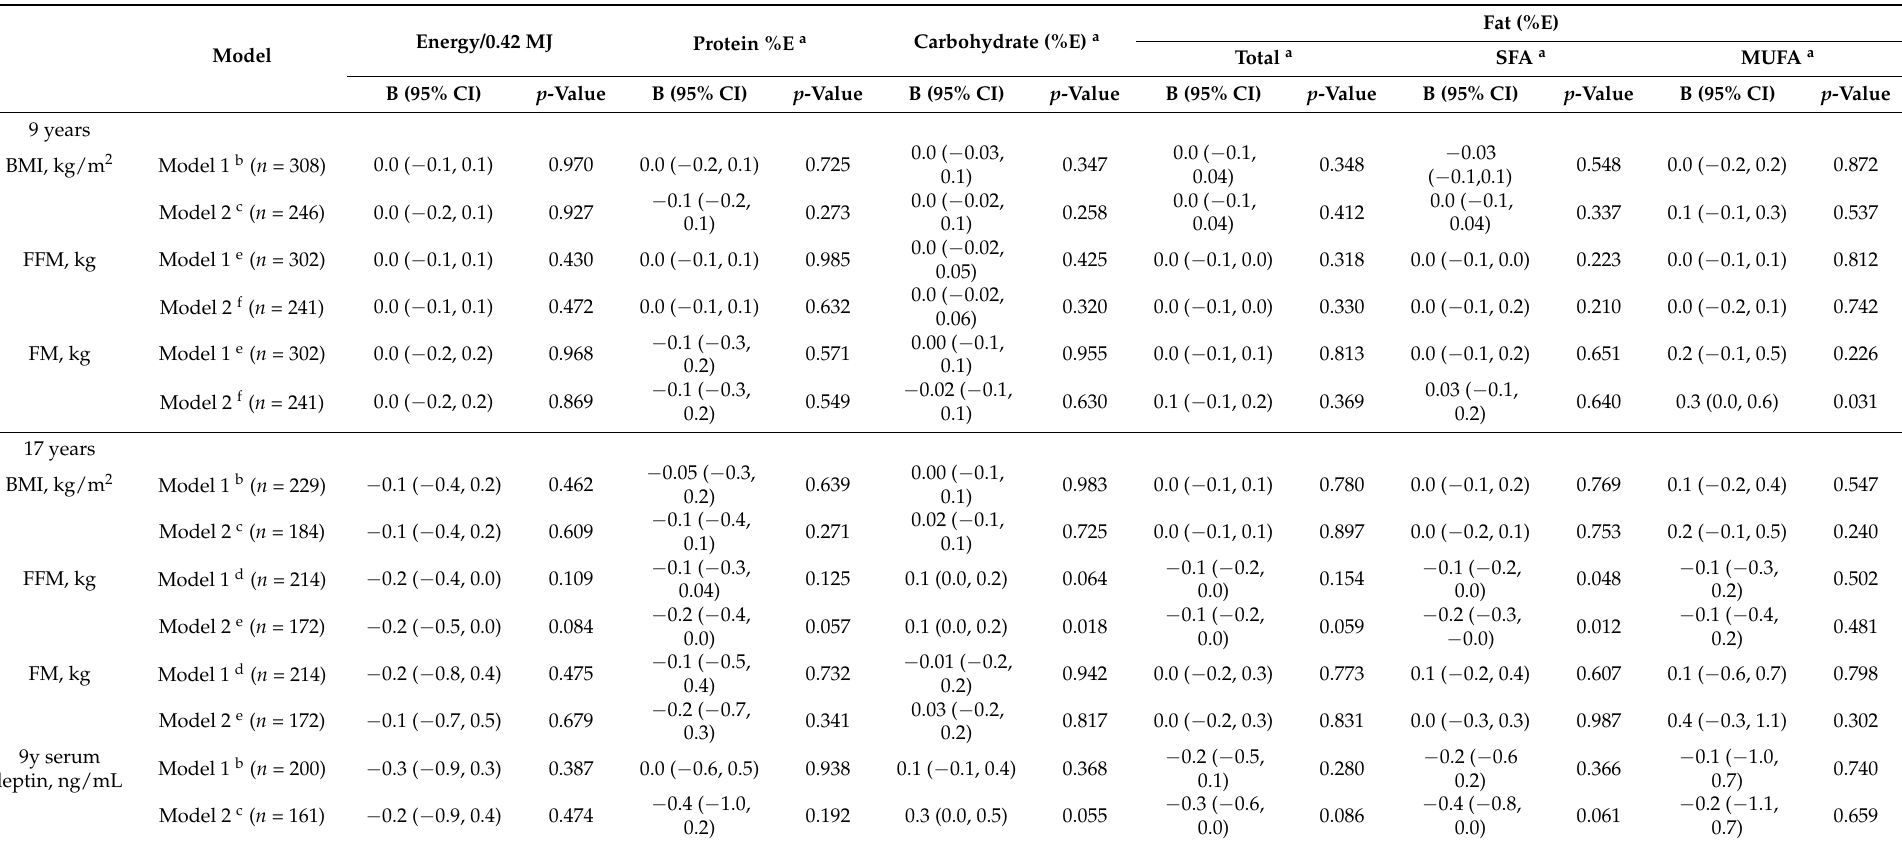
Table 4. Multiple linear regression models for energy and energy − adjusted macronutrient intakes of girls, using diet collected at 18 months of age to predict body composition and serum leptin concentration at 9 years of age and body composition at 17 years of age in children enrolled in ALSPAC −